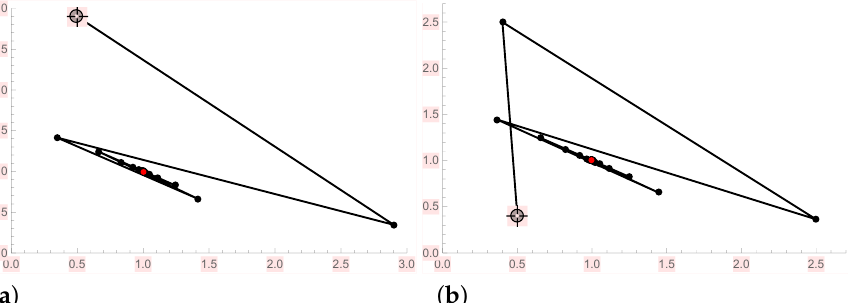
Figure 5. Visualization of Conjecture 4 with A = F = 0.5 and initial conditions: ( a ) ( x 0 , x − 1 ) = ( 0.5,2.9 ) , ( b ) ( x ) = ( 0.5,0.4 ) 0 , x − 1